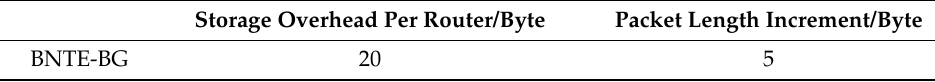
Table 2. Storage increment of